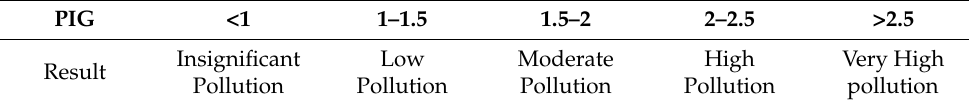
Figure 5. Technical roadmap of the improved PIG method. Table 3. Five categories of water for drinking purposes according to three PIG values [15].